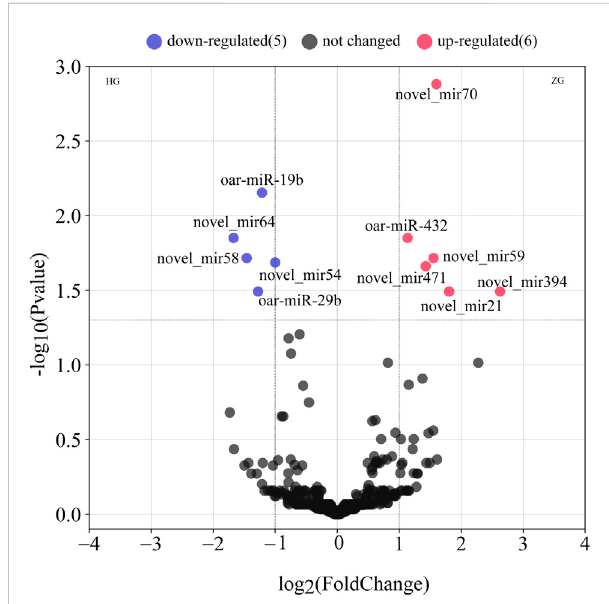
Result of the luciferase reporter assay. (A) Potential binding site between oar-miR-432 and SIRT13 ’ UTR. The underlined sequences represent the mutant sites. (B) WT exhibits the psiCHECK2-SIRT1- 3 ’ UTR-WT. MT exhibits psiCHECK2-SIRT1-3 ’ UTR-MT. psiCHECK2 exhibits psiCHECK2 pure vectors. Mimics exhibits oar- miR-432 mimics. NC exhibits negative control. **: indicates statistically signi fi cant ( p <